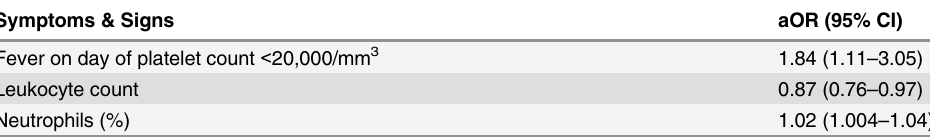
1.02 (1.004 – 1.04)